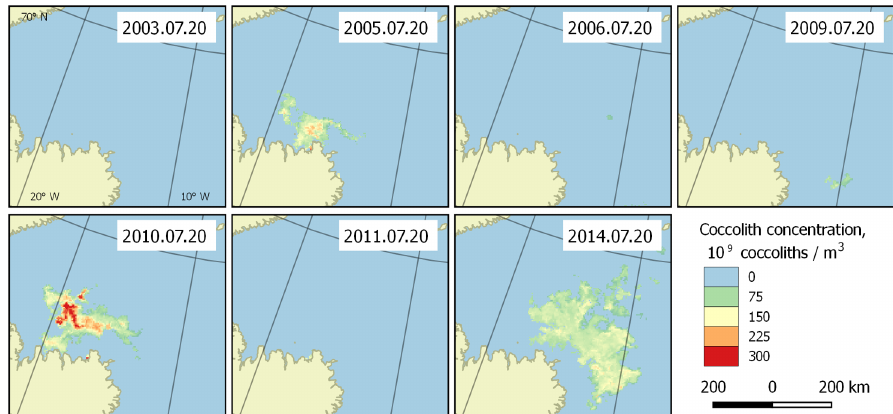
Figure 6. Bloom intensity in the Greenland Sea (region 2) on 20 July in different years. Its instability is